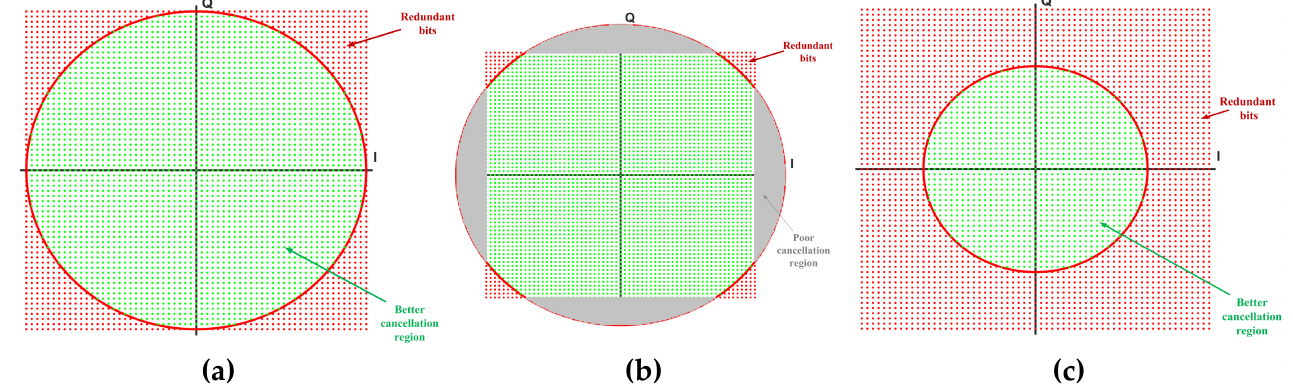
Figure 8. Possible cancellation points and power region of the self-jamming signal. ( a ) The self- jamming signal can be canceled in all cases; ( b ) the cancellation accuracy will be affected at the boundary in the circular area; ( c ) the amplitude control will produce redundant control bits.